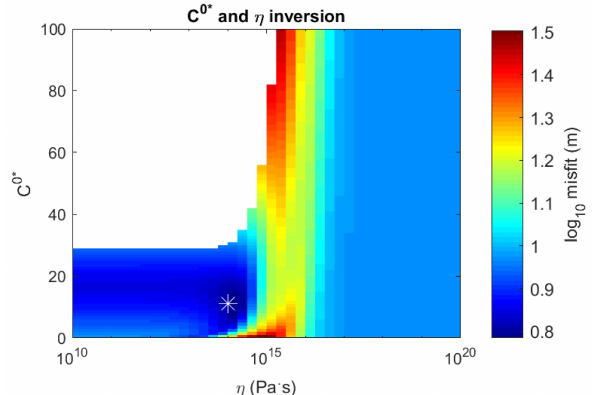
Figure 5. Misfit minimization for η and C 0 ∗ between the ice surface DEM and ice surfaces predicted by bed topography transfer in study region R1 (Fig. 1a, Table 1). The white star indicates the location of minimum misfit, at C 0 ∗ = 10 and η = 10 14 . The blank plot area is the region where parameters are nonphysical (resulting in transfer amplitudes >